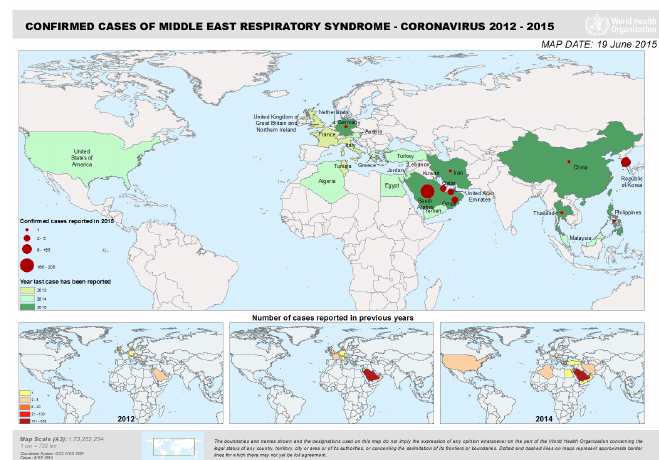
Figure 1. Countries with confirmed MERS cases as of June 19,